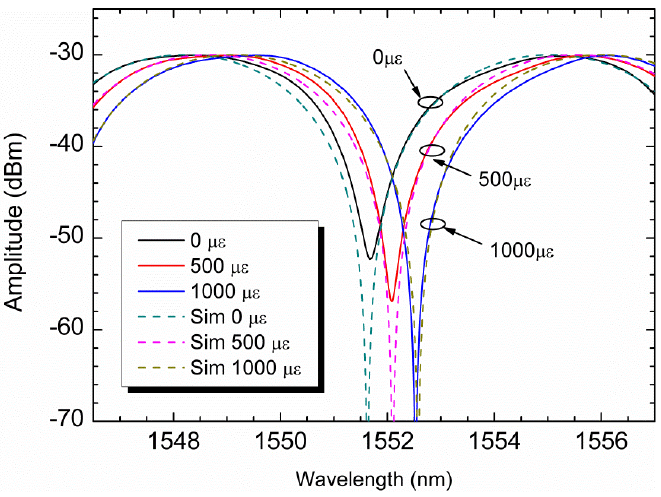
Figure 4. Experimental results (solid line) and theoretical simulations (dash line) of the reflected output signal for three different strain induced